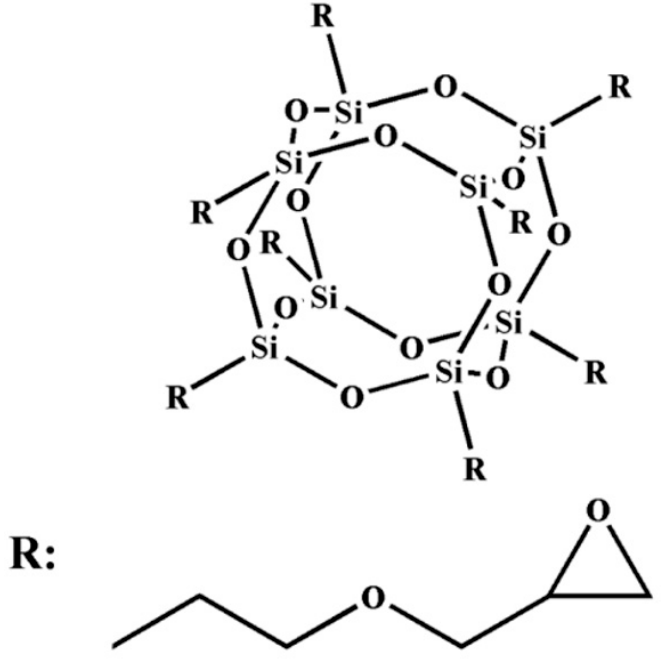
Figure 1. The molecular structure of epoxy resin–polyhedral oligomeric silsesquioxane